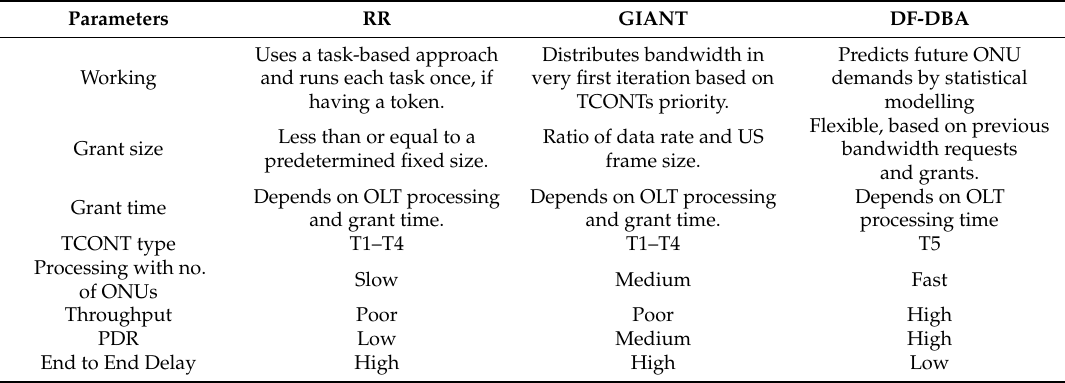
Table 4. A brief comparison of round robin (RR), GigaPON access network (GIANT) and